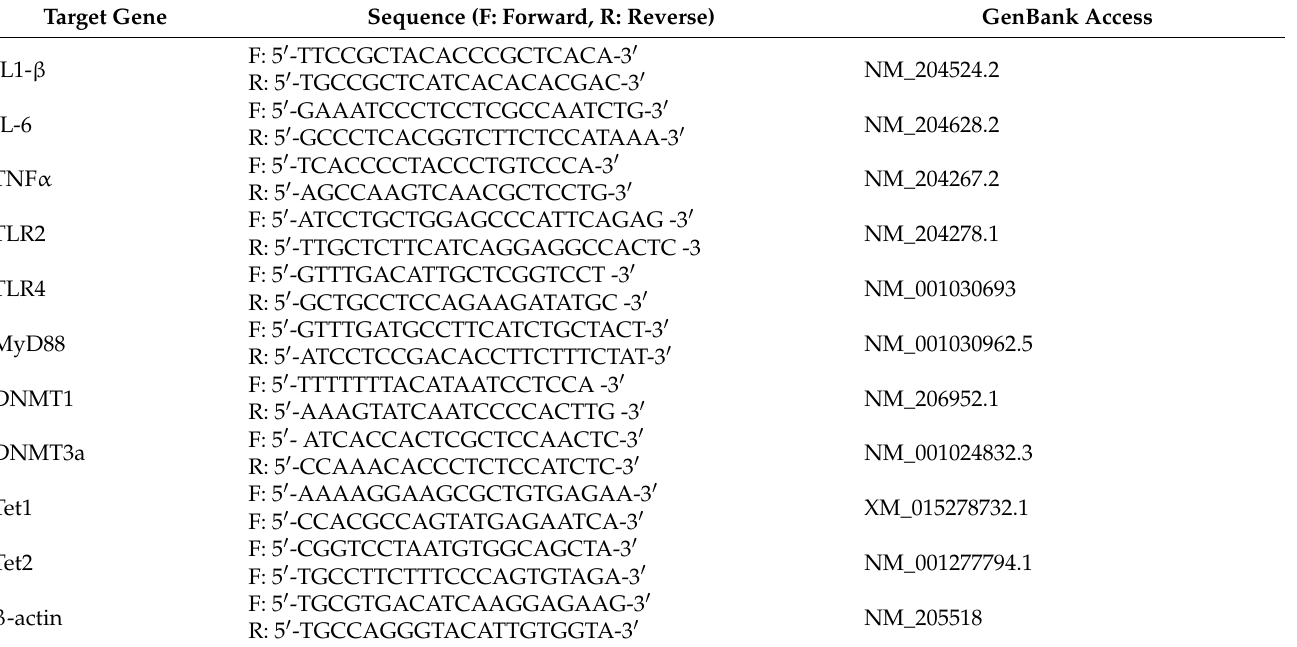
Table 1. Nucleotide sequences of the specific primers used in real-time PCR. Target